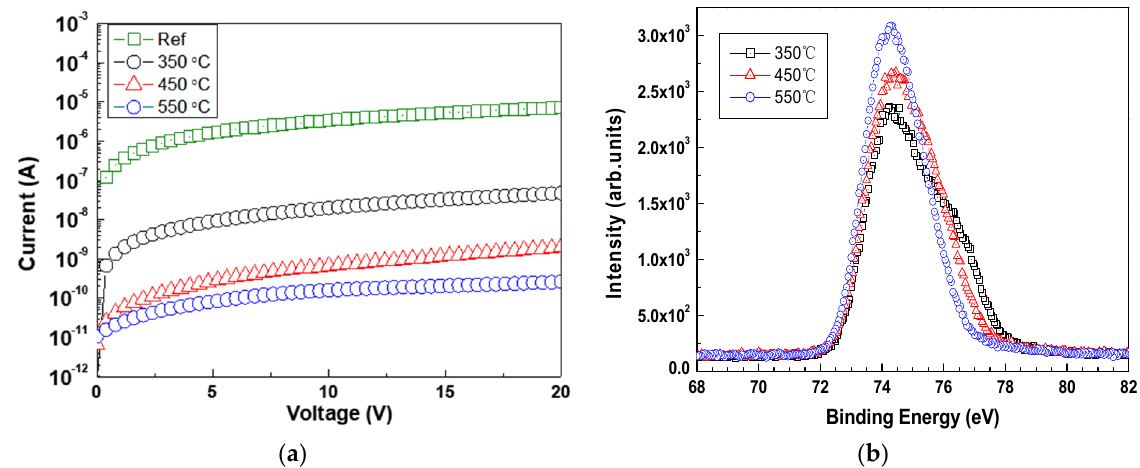
Figure 5. ( a ) Current–voltage (I–V) characteristics of diode and ( b ) X-ray photoelectron spectroscopy (XPS) depth profile analysis of Al 2 O 3 /GaN interface by varying the atomic layer deposition (ALD) growth temperature from 350 °C to 550 °C.